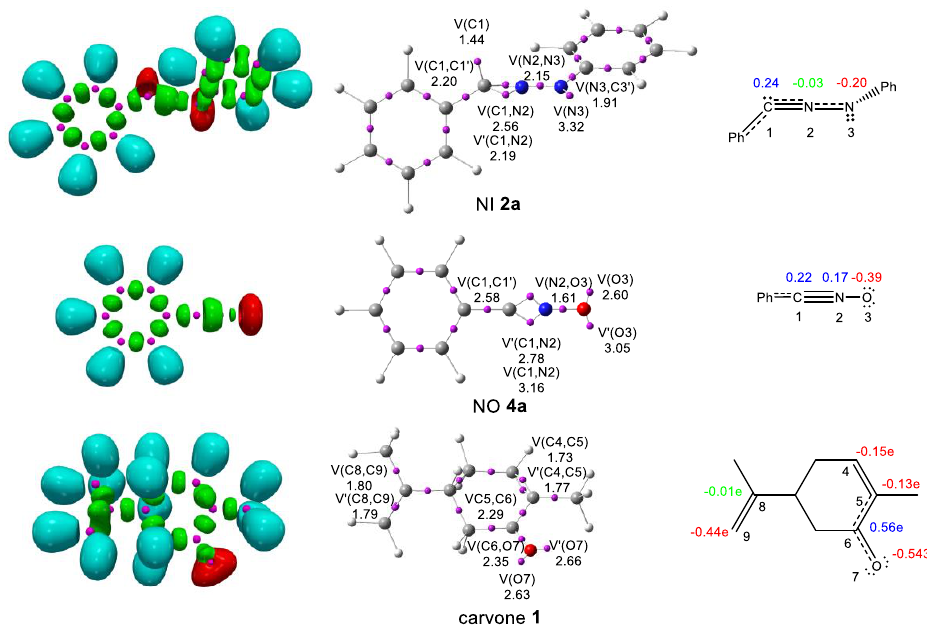
Figure 1. B3LYP / 6-31G(d) ELF localisation domains, represented at an isosurface value of ELF = 0.75, ELF basin attractor positions, together with the valence basin populations, and the proposed ELF-based Lewis-like structures, together with the natural atomic charges, of diphenyl-NI 2a , phenyl-NO 4a and (R)-carvone 1 . For ELF localisation domains, protonated domains are coloured in turquoise, disynaptic domains in green, monosynaptic domains in red, and core domains in purple. For the geometries, the standard colour code for chemical elements is used, while the attractors of ELF basins are coloured in purple. For charges, negative charges are coloured in red, positive charges in blue and negligible charges in green. ELF valence basin populations and natural atomic charges are given in average number of electrons,